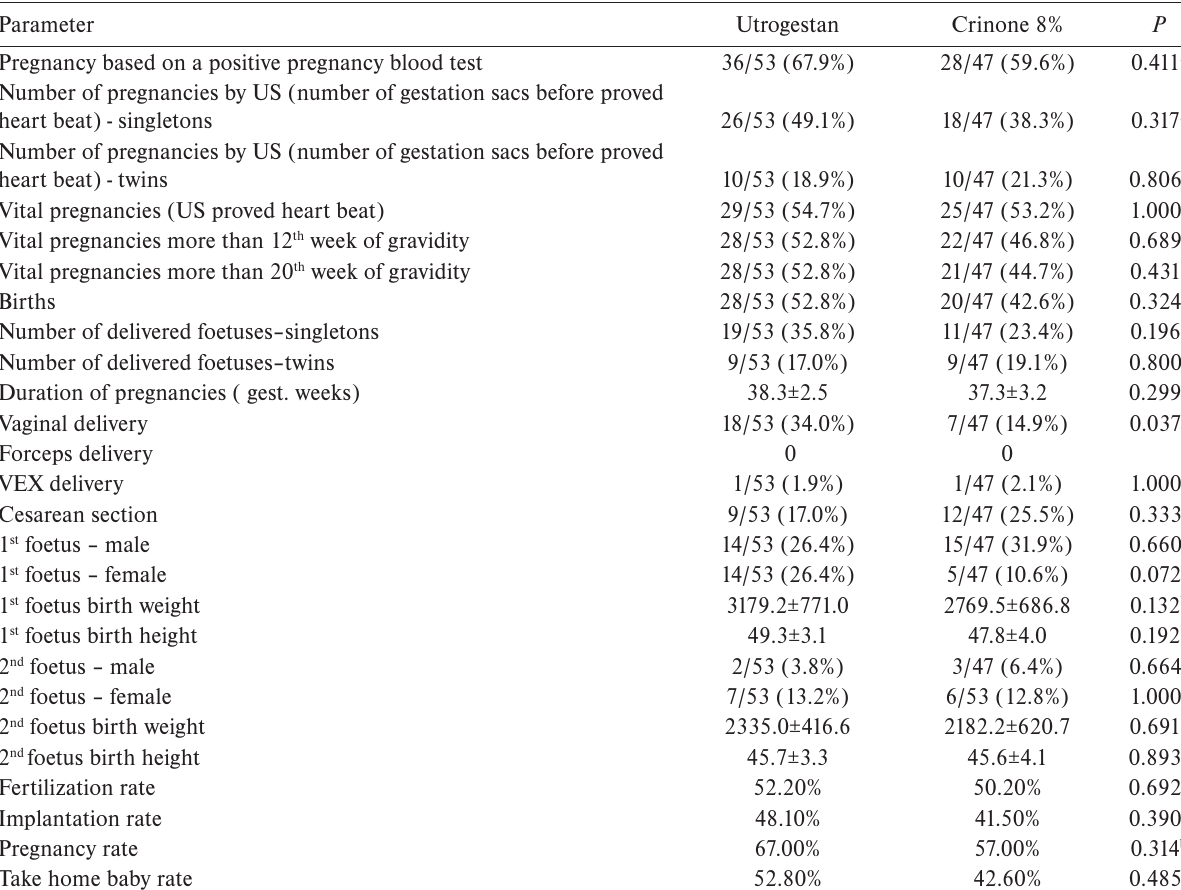
Table 2. Results for